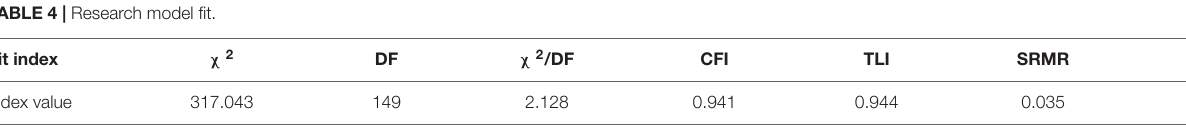
TABLE 4 | Research model fit.